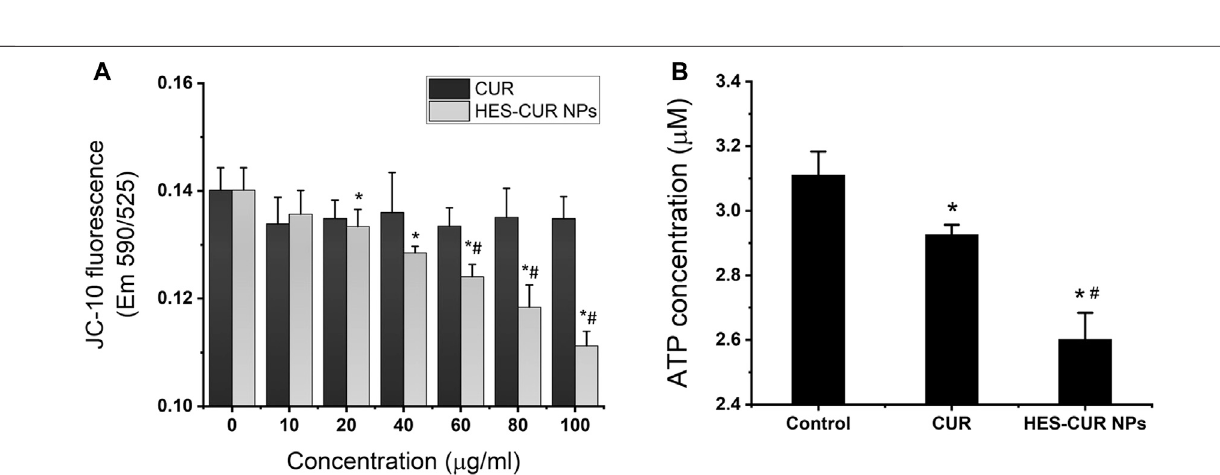
Frontiers in Pharmacology |